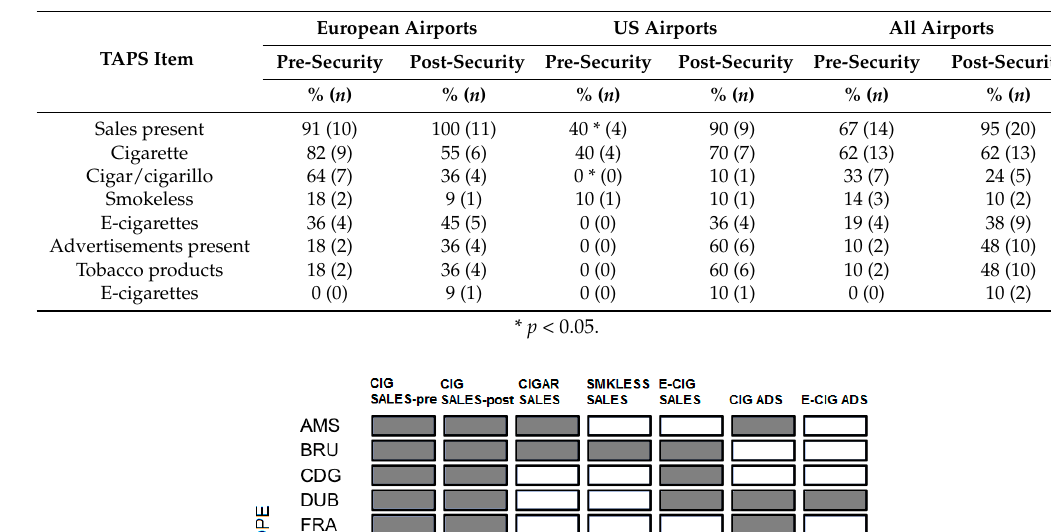
Table 1. Presence of TAPS observed in airports in Europe and the US, by location, 2014.